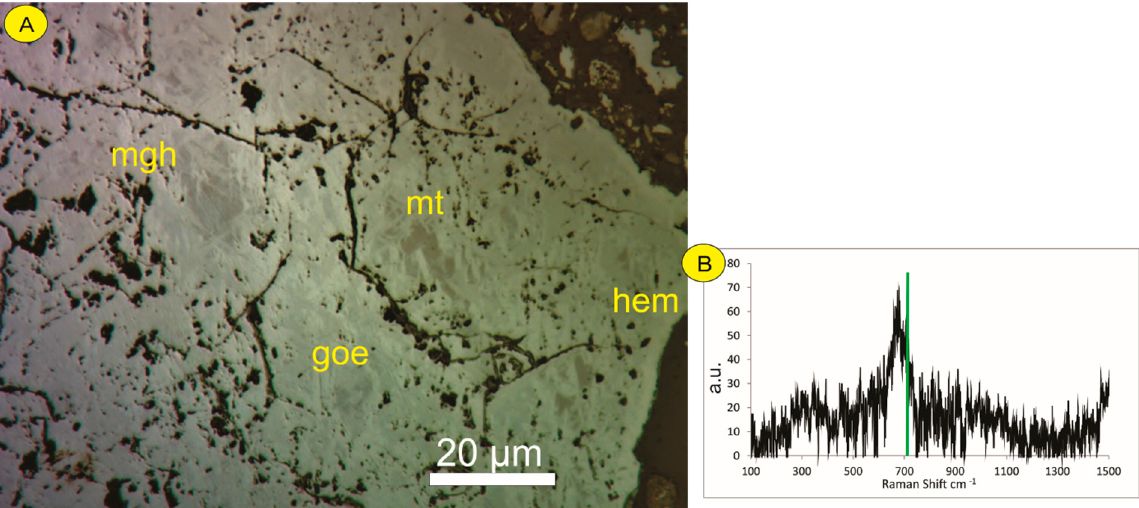
Figure 6. ( A ) N4WS hematite grain observed by reflected light microscopy in bright field mode: hematite (hem, light gray), maghemite (mgh, bluish gray), magnetite (mt, pinkish gray) and goethite (goe, dark gray); ( B ) Raman spectrum of maghemite with marker at the diagnostic vibration at 720 cm − 1 , measured at the mgh domain in ( A ).